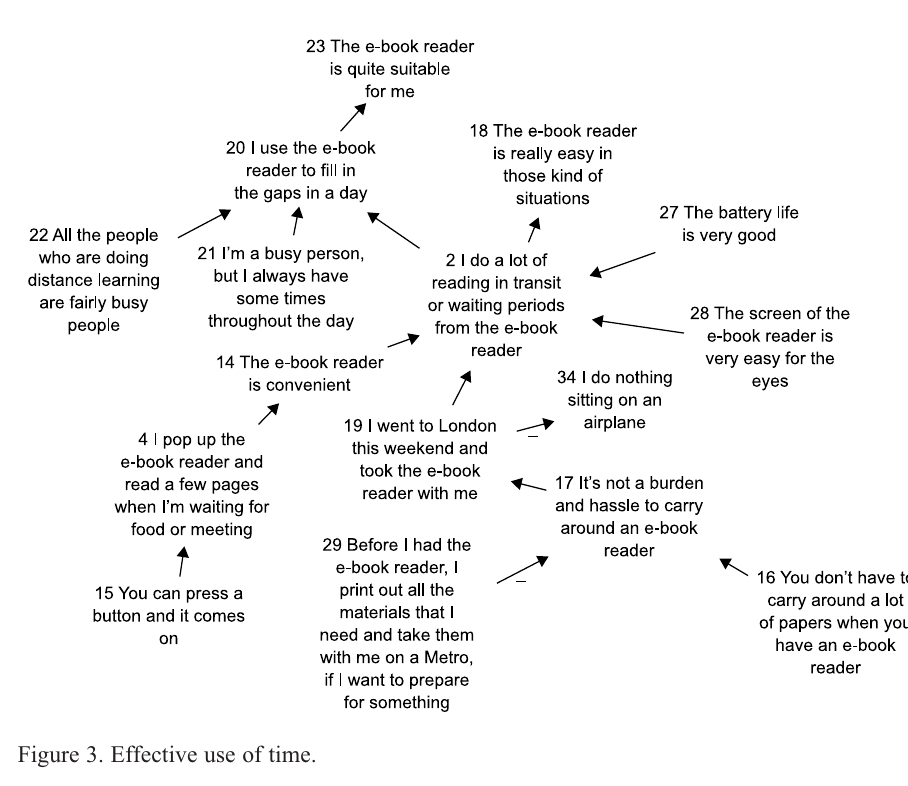
Table 5. Has the e-book reader changed students’ study? Has the e-book reader changed the way you